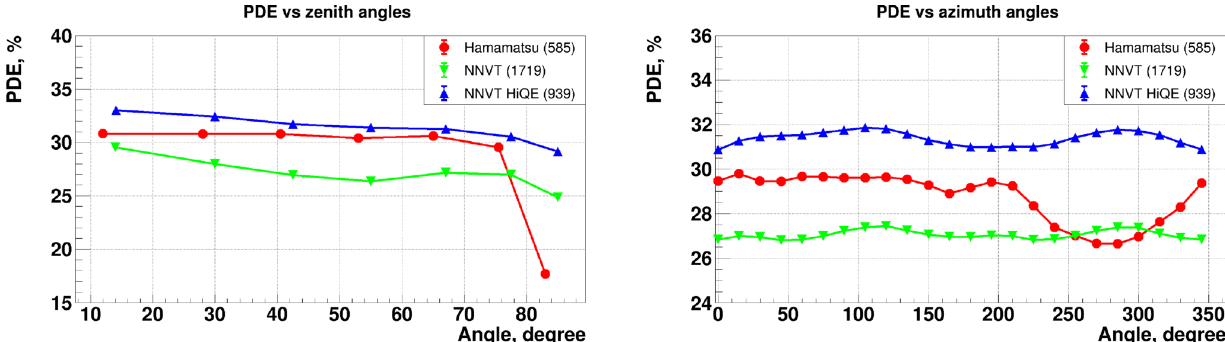
Fig. 38 Uniformity of PDE along the zenith angle ( θ , left) and azimuthal angle ( φ , right). Blue,: HPK PMTs; red: NNVT low-QE PMTs; green: NNVT high-QE PMTs